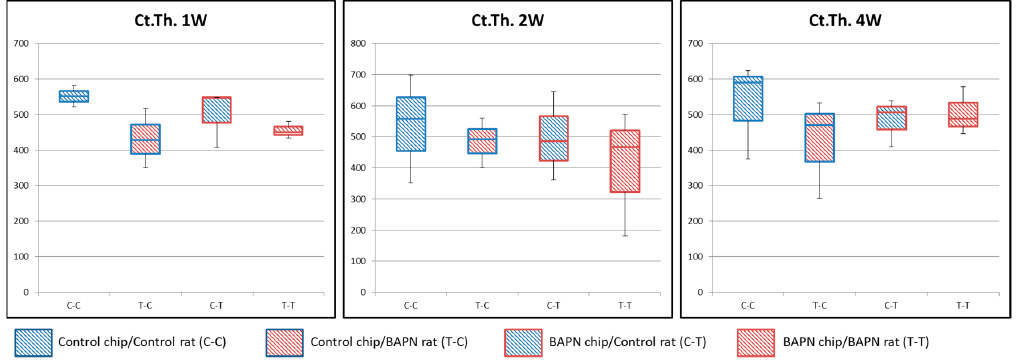
Figure 4. Cortical thickness of transplanted bone chips. No significant difference in cortical thickness is seen among all conditions.